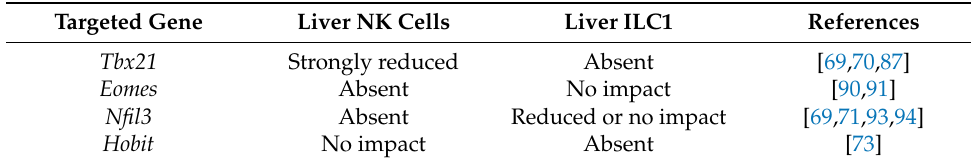
Table 2. Consequences of the loss of key transcription factors on liver ILC1 and NK cell homeostasis in